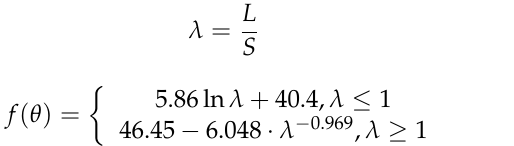
T a Figure 4. IGBT equivalent computing network for the thermal resistance model. According to Figure 4, the coolant temperature and IGBT thermal loss can be calcu ‐ lated for the IGBT and FWD diode, respectively:  